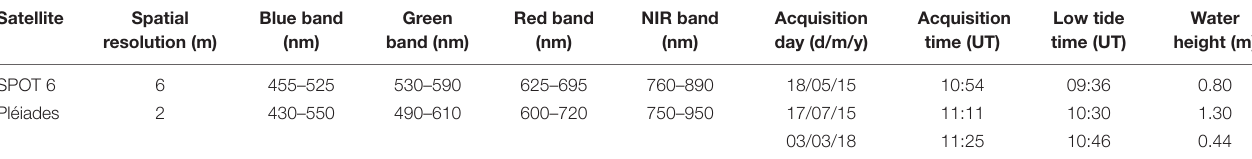
TABLE 1 | Satellite image characteristics used to map the horizontal distribution of the MPB biomass, expressed in NDVI.